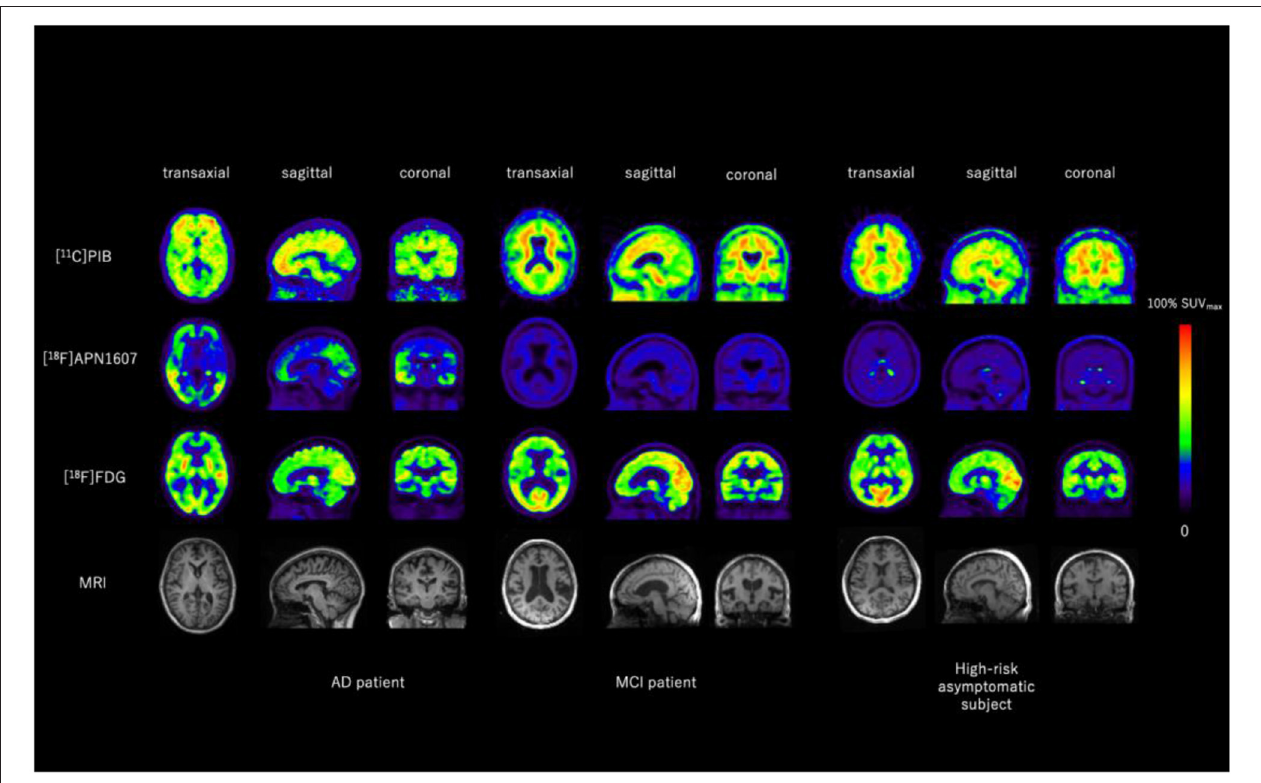
FIGURE 3 | Representative images of [ 11 C]PIB, [ 18 F]APN1607, and [ 18 F]FDG PET and MRI of an AD patient, an MCI patient and a high-risk asymptomatic subject. A β was positive for the AD patient and equivocal for the MCI patient and the high-risk asymptomatic subject. Typical Braak Stage V–VI tau deposition was seen in the AD brain, whereas no tau deposition was seen in the brain of the MCI patient or the high-risk asymptomatic subject. Typical AD-like glucose-hypometabolism was seen in AD brain including posterior cingulate cortex, parietal, temporal, and pre-frontal cortices, whereas most of these regions are relatively spared in the brain of MCI patient and high-risk asymptomatic subject. Images provided by PET Center, Huashan Hospital, Fudan